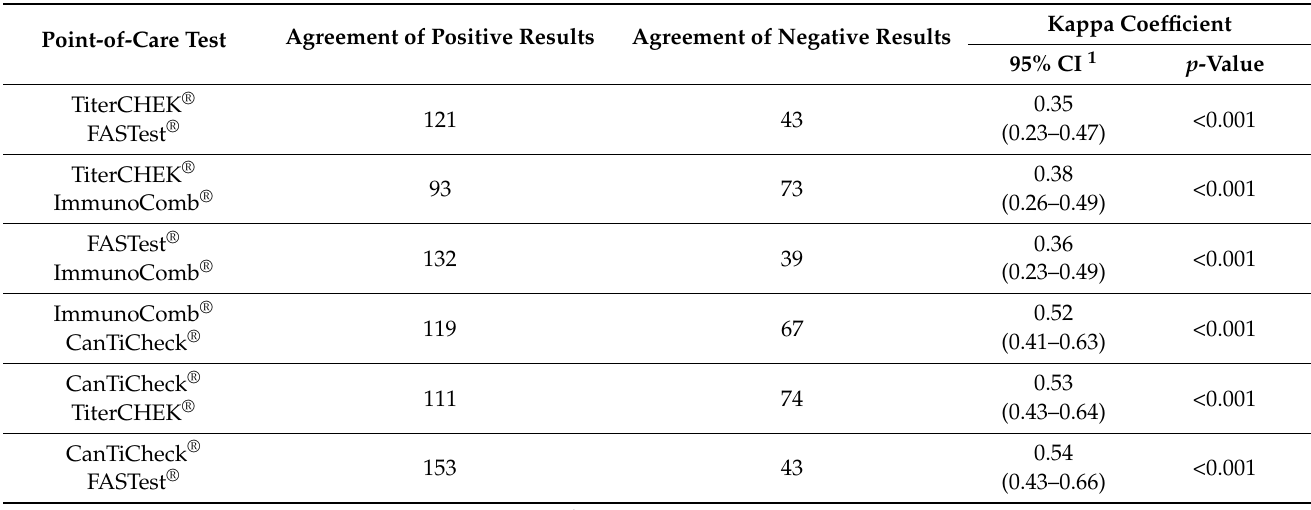
Table 6. Agreement of the results of the four point-of-care tests, using Cohen ´ s kappa statistic in all